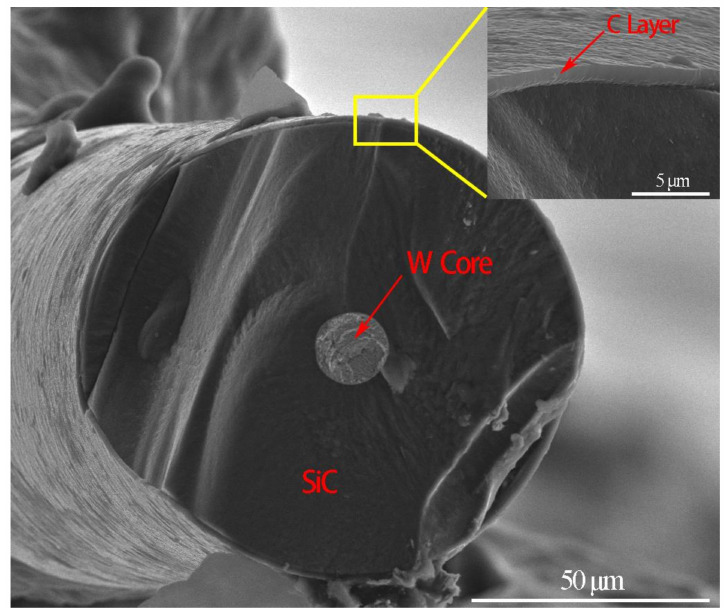
Figure 1. Morphology of SiC fiber.